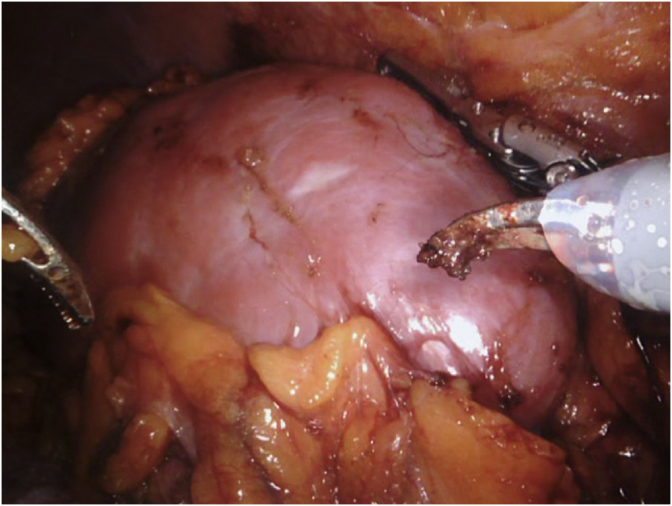
Removal of almost entire perirenal fat deposition.